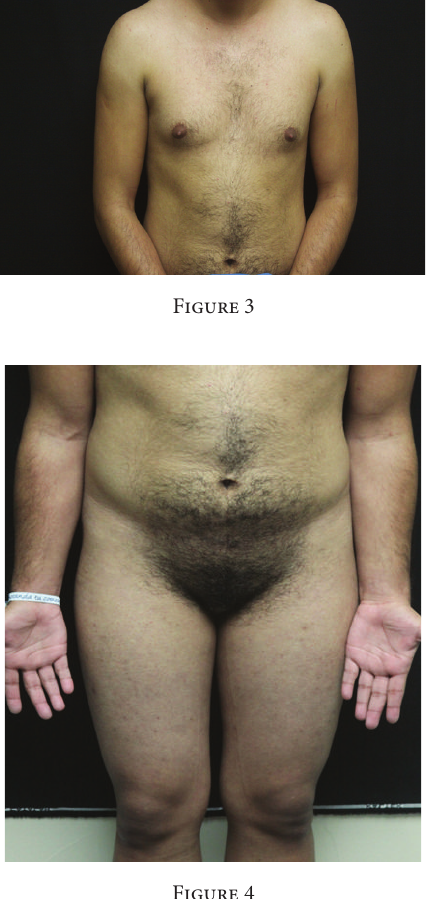
and metoprolol for 6 weeks, plasmatic methanephrines, urinary metanephrines, and plasma aldosterone concentra- tion/plasma renin activity were found to be normal (Table